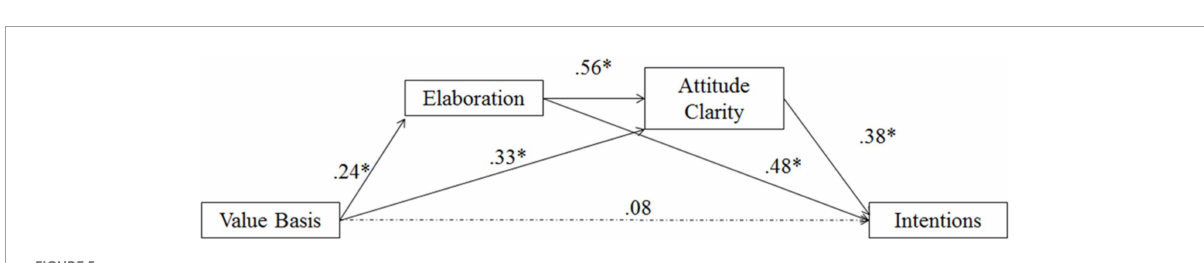
0.01 to 0.14; see Figure 5 ). The direct effect of the value basis manipulation was no longer significant [ b = 0.08, SE =